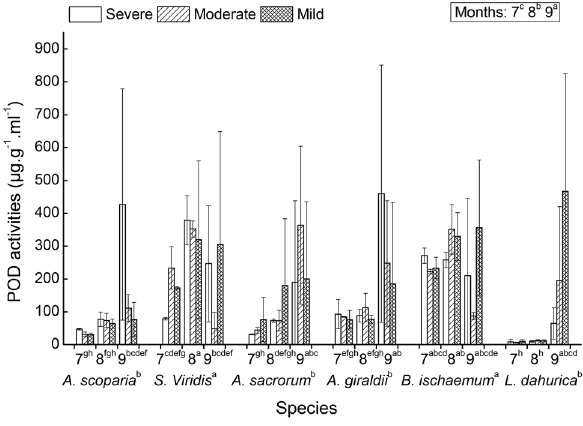
deficit The POD activities were significantly different among the six seral species and the three growing months (Table 1). S. viridis, and B. ischaemum had relative higher POD activities than other species had. And the POD activities showed an increase tendency along the growing season of those three months (Fig. 3). In July, August and September, the POD activities were at low, medium and the highest levels, respectively. No significant differences of POD activities were found among the water deficient levels.